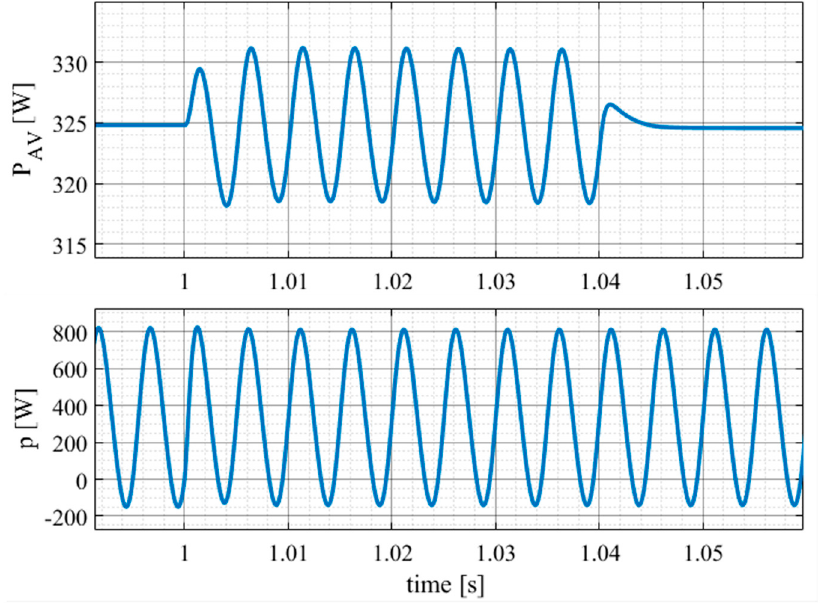
Figure 7. Time waveforms of P av and p —case of compensation (top) P av during compensation (top); (bottom) p during compensation (stays constant).